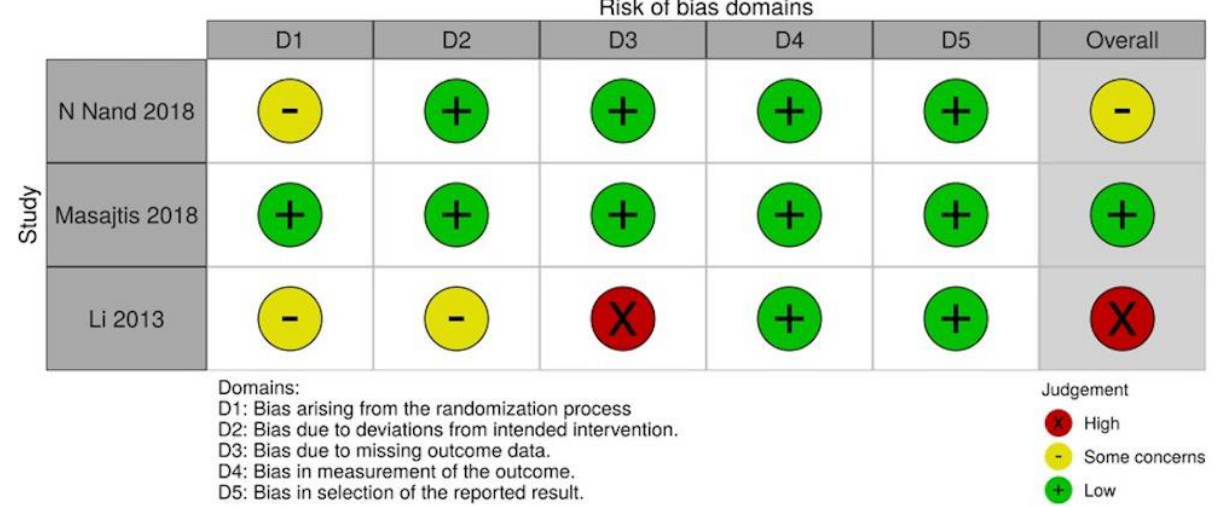
Figure 2. Risk of bias of randomized controlled trials.